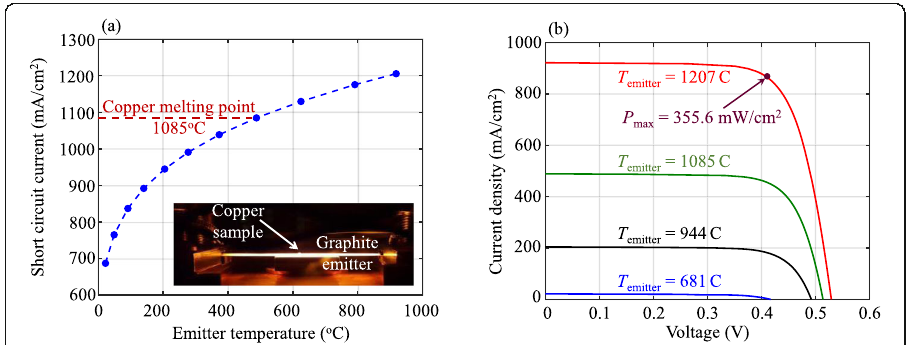
Fig. 4 Calibrating graphite emitter temperature by means of short circuit current measurement. In the first step, short-circuit current is at a reference temperature T = 1085 °C, the melting point of copper, on top of the graphite strip emitter, as shown with the inset in ( a ). The short circuit current in ( b ) calibrates temperatures at T ≠ 1085C from the corresponding black body spectra at each